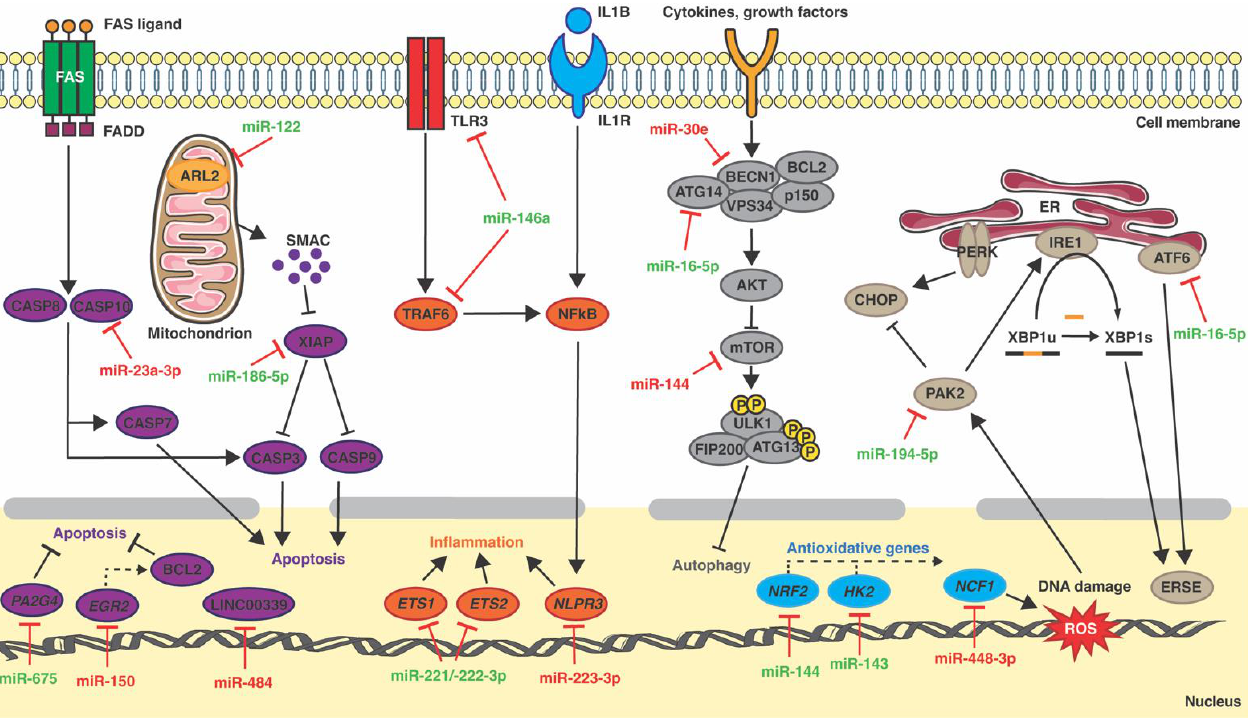
Figure 2. MiRNAs in cardiomyocyte inflammation, ER stress, mitochondrial dysfunction, oxidative stress, autophagy and apoptosis pathways. Green and red represent upregulated and downregulated miRNAs in the disease, respectively. FAS, fas cell surface death receptor; FADD, fas-associated death domain protein; CASP8, caspase-8; CASP7, caspase-7; CASP3, caspase-3; IL1R, interleukine- 1 receptor; NFkB, nuclear factor kappa B; AKT, protein kinase B; mTOR, mechanistic target of rapamycin; CHOP, C/EBP homologous protein; ERSE, ER stress response